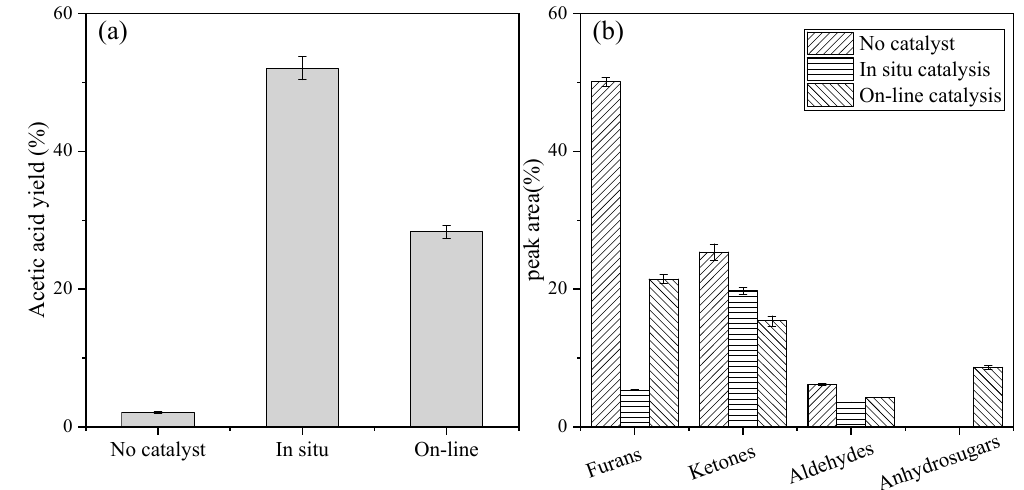
Figure 2. Comparison of the acetic acid (AA) yields ( a ) and product distributions ( b ) of the glucose pyrolysis with (both in situ catalysis and on-line catalysis) and without a catalyst at 350 °C for 30 s.